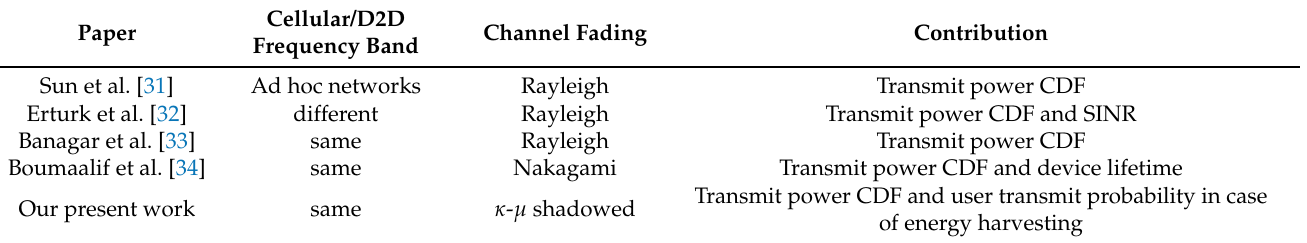
Table 1. Contribution of this work related to literature review.